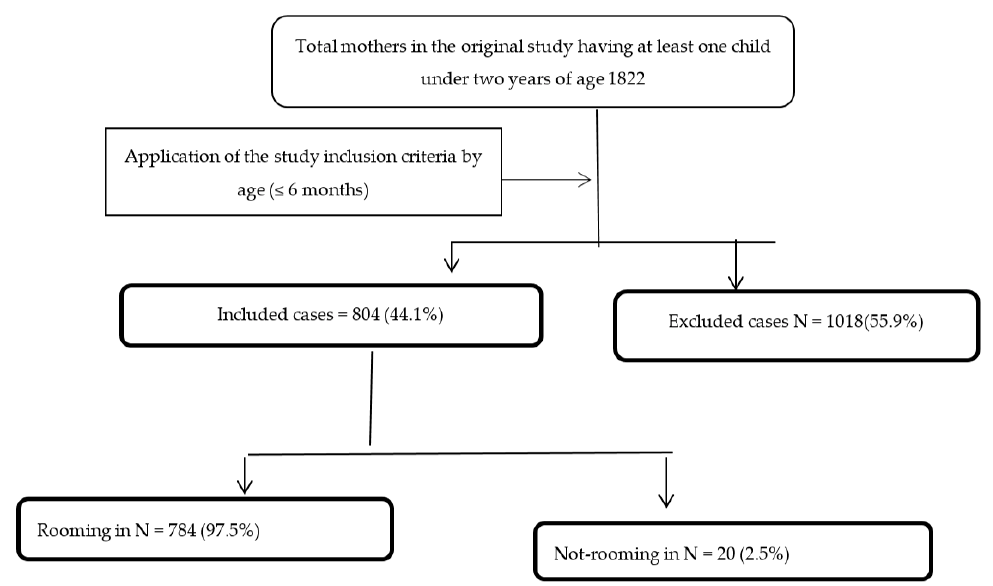
Figure 1. Study participants’ flow chart and main